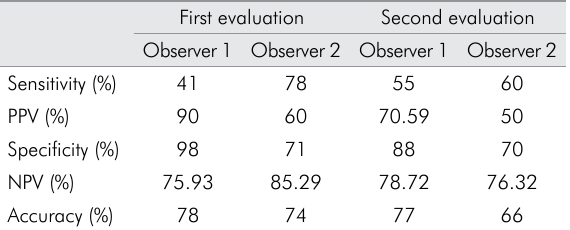
Table 4. Sensitivity, positive predictive values, specificity, negative predictive values and accuracy rates (%) calculated according to diagnosis of oroantral communication caused by periapical lesions.